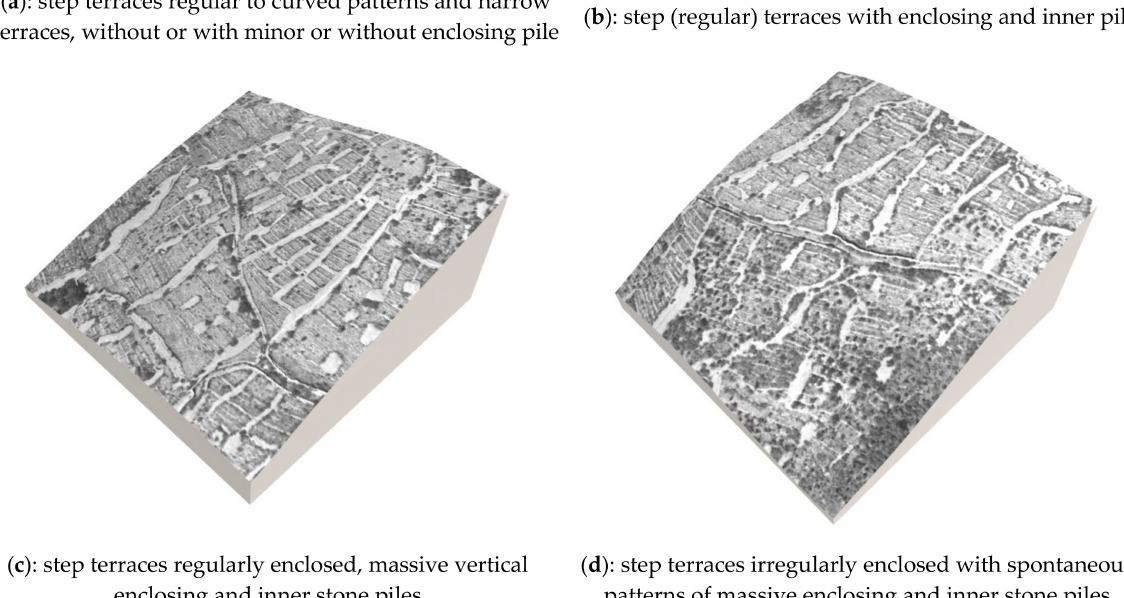
Figure 32. Dry stone wall karst terraces representative of the Cres olive grove. Elaboration is based on aerial imagery from 1953 and digital elevation